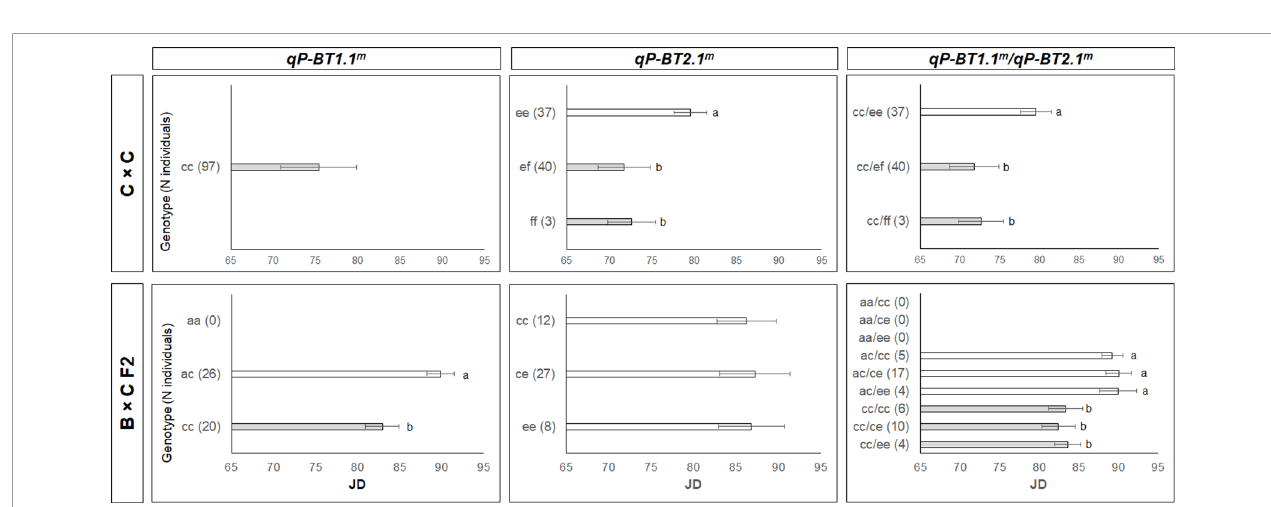
FIGURE 5 | Bloom time (BT) mean values for offspring based on the haplotypes for the major quantitative trait loci (QTLs) detected on LG1 (qP-BT1.1m) and LG2 (qP-BT2.1m) individually and the two QTLs together. The offspring are from the two F2 populations (C×C and B×C F2). Signi fi cant differences between genotypes are indicated by different letters (P <